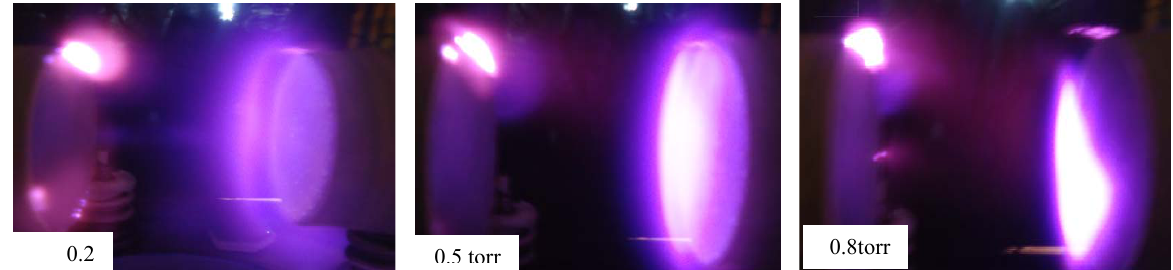
0.5 torr0.2 0.8torr Fig. 3: Photographs of discharge regions at different pressures without Al dustparticles.